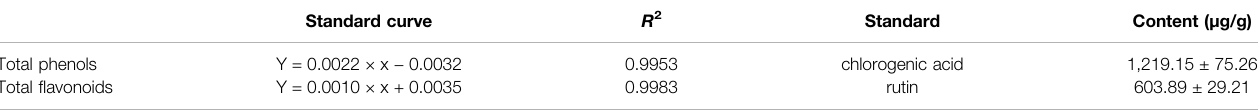
TABLE 1 | The total phenols and fl avonoid contents in BBJ.